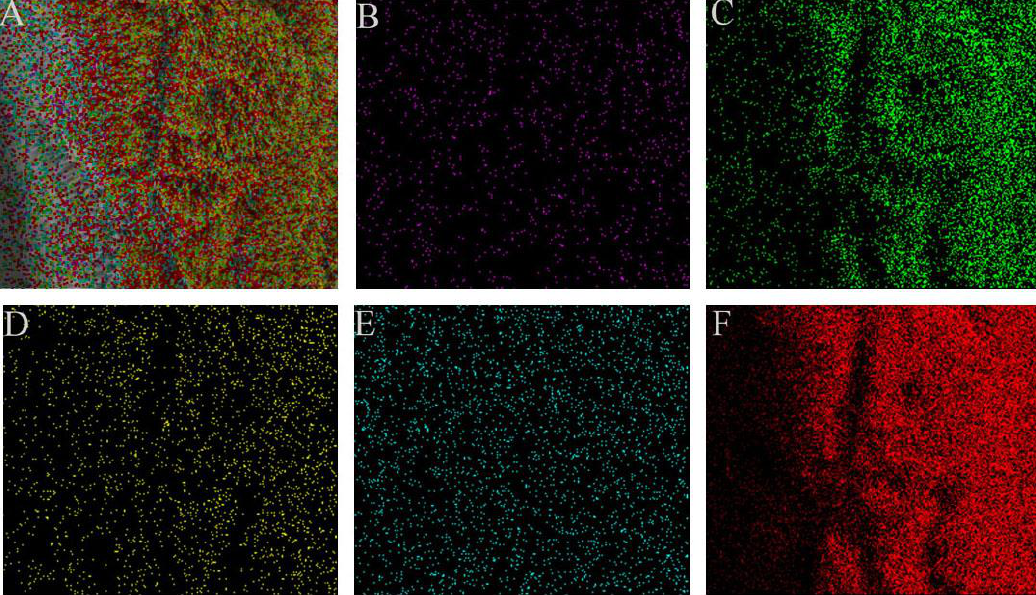
Figure 2. Element distribution at Solution concentration 40 mmol/L, reaction time 4 h, reaction temperature 95 °C: ( A ) Overall distribution of elements. ( B ) Purple: C element. ( C ) Green: O element. ( D ) Yellow: Al element. ( E ) Blue: Ni element. ( F ) Red: Zn element.